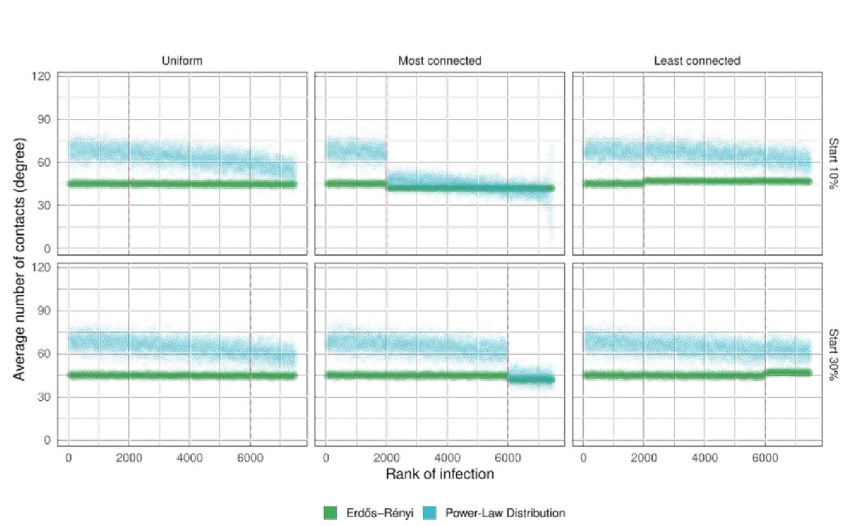
Fig 4. Effect of the vaccination strategy on the rank of infection. The dots represent averages over 30 simulations. The number of doses of the vaccine represents 25% of the population size (N = 20000). In these simulations we vaccinate individuals regardless of their status (S, I, R). Vertical dashed lines indicate the time when the intervention is made.